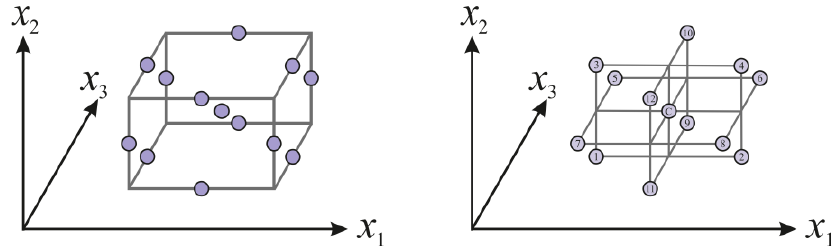
Figure 1. Box-Behnken experimental method .